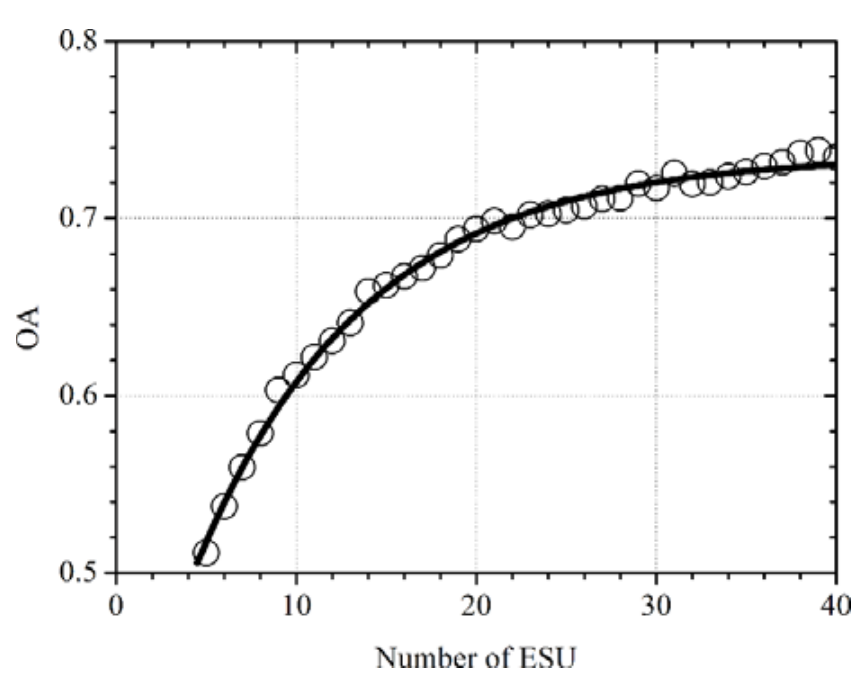
Figure 3. The spatial distribution of the 20 elementary sampling units for the multi-temporal constrained sampling design in the feasible region.